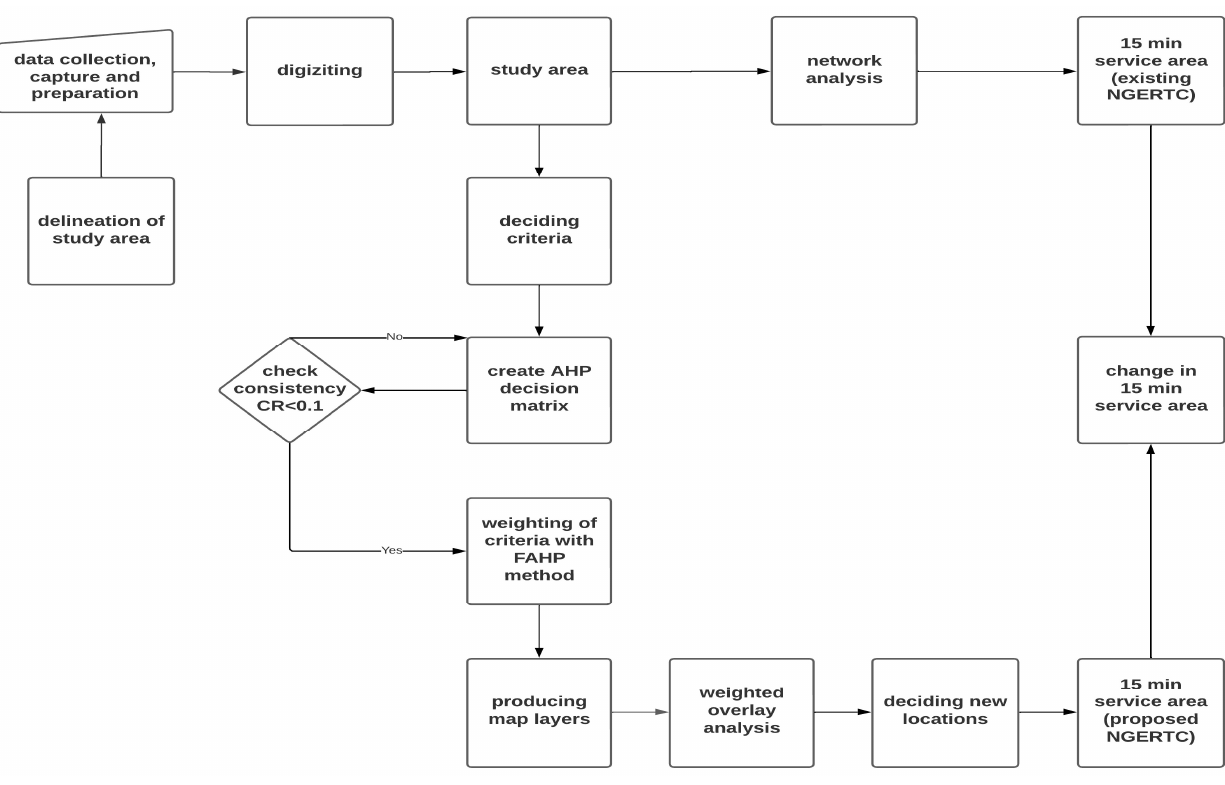
Figure 4. The workflow of site selection study of natural gas emergency response team centers.